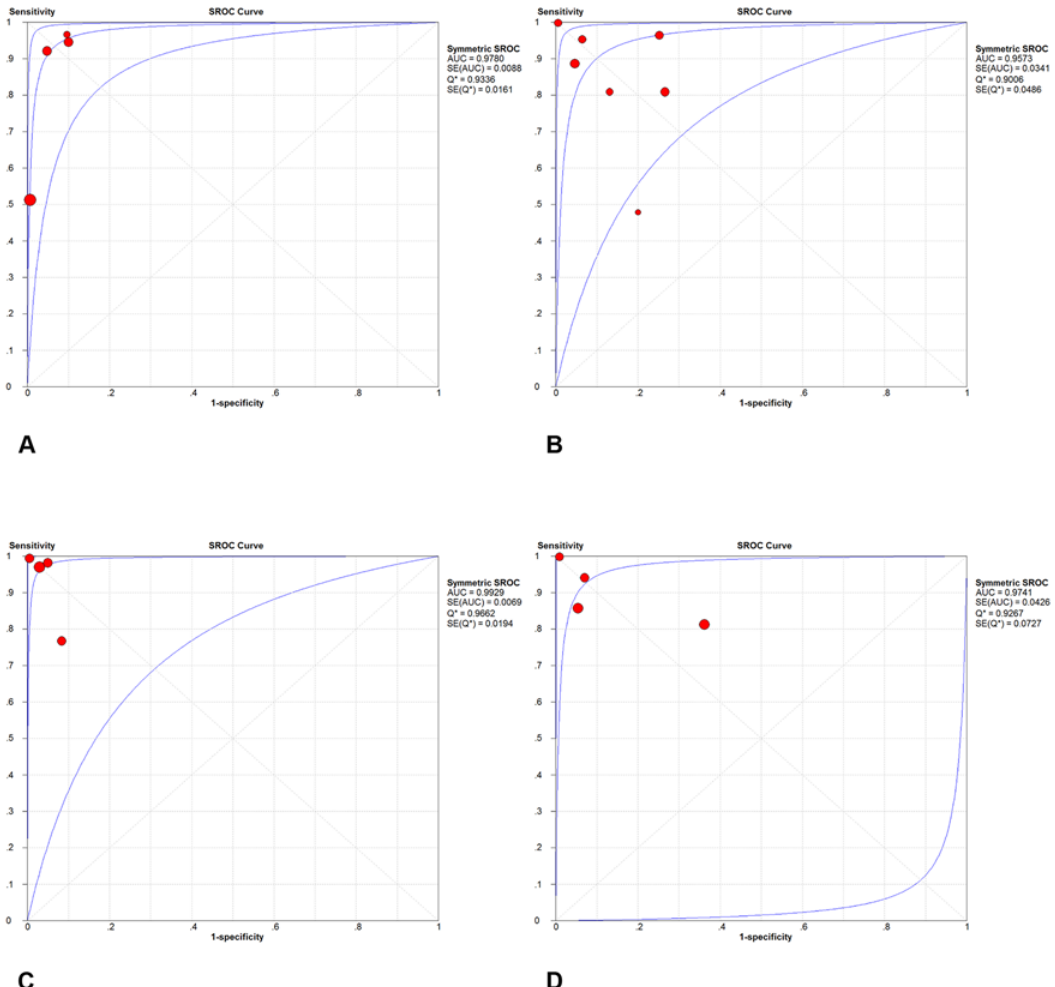
Fig 5. Summary ROC curve for CT. Diagnostic performance of CT in (A) patient basis; (B) total arteries; (C) main + lobar arteries; (D) segmental arteries.